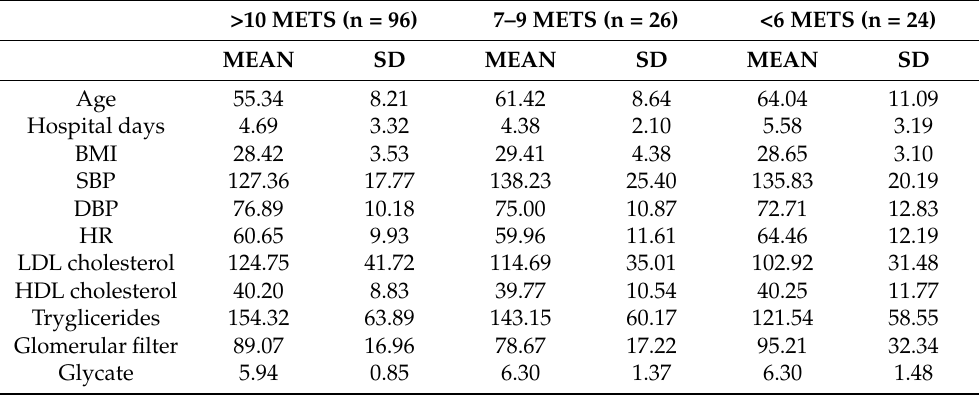
Table 1. Mean and standard deviation in the three groups of the following variables: Age (in years), days in the hospital from the admittance to hospital to discharge, body mass index (BMI), systolic and diastolic blood pressure (SBP and DBP), heart rate (HR), cholesterol HDL and LDL, level of triglycerides, glomerular filter and